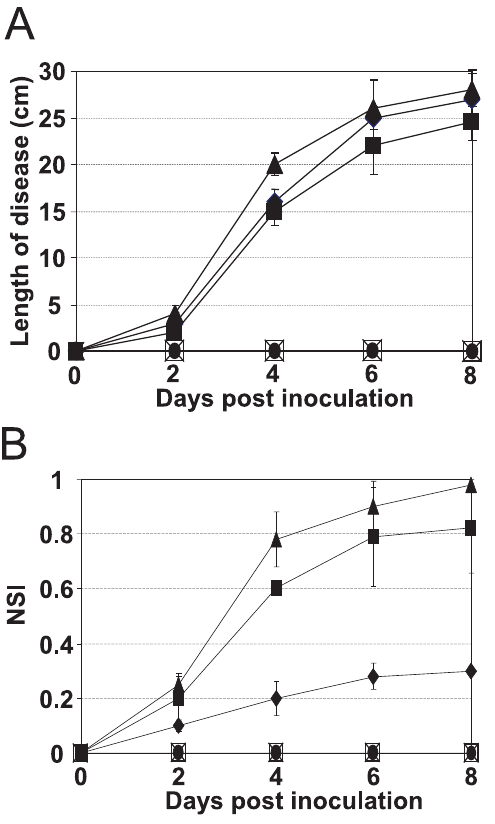
Figure 4. Disease severity of Erwiniaamylovora wild-type (WT) strain, amyR mutant, complementation strains and WT con- taining pAmyR2 plasmid on apple plants. A . Gala shoots. B . Red Delicious leaves. NSI is the necrosis severity index calculated as described (Wang et al., 2010). ¤ : Ea1189, & :Ea273, m : D amyR , Ea1189 (pAmyR2), % : Ea273 (pAmyR2), 6 : D amyR (pAmyR2). Data points for Ea1189 (pAmyR2), Ea273 (pAmyR2) and D amyR (pAmyR2) overlap because no disease symptoms were observed. Figure 5. Virulence tests on immature pear fruits. A . Symptoms